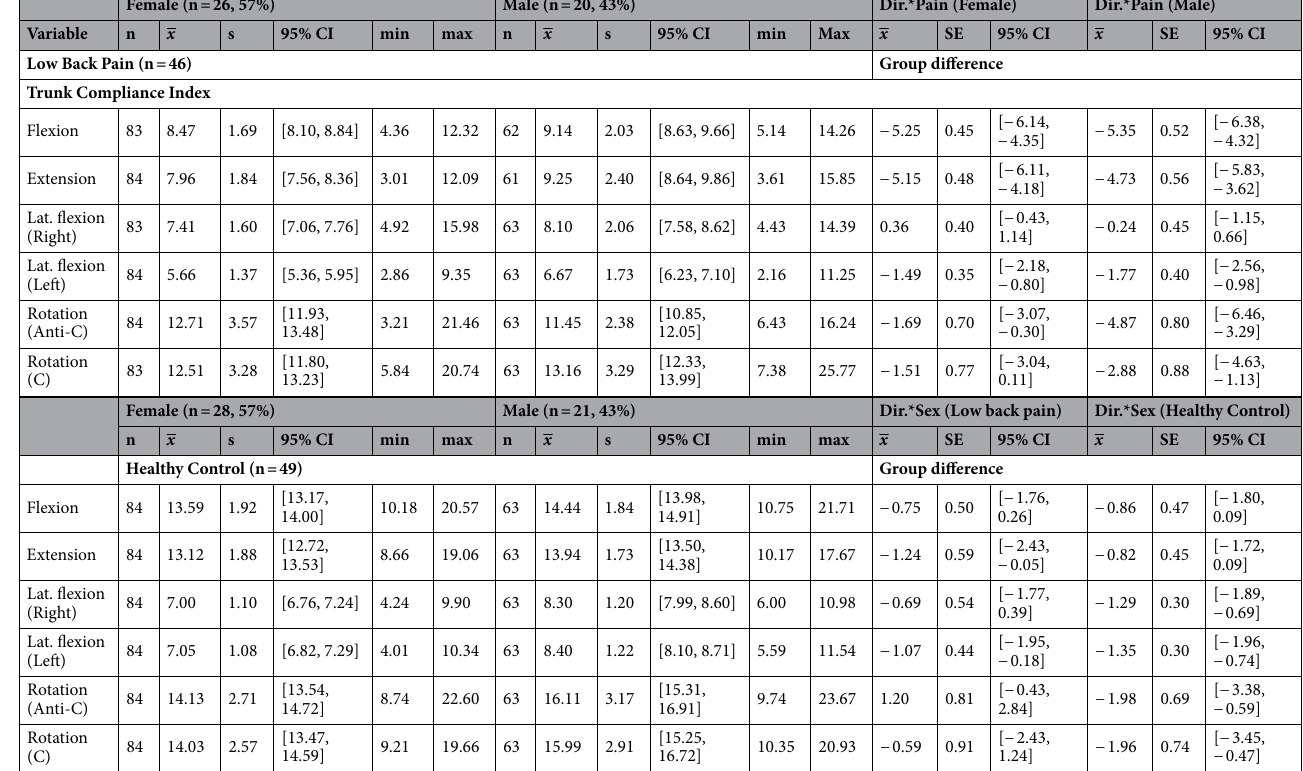
Table 2. Comparison of Trunk Compliance Index between pain condition and